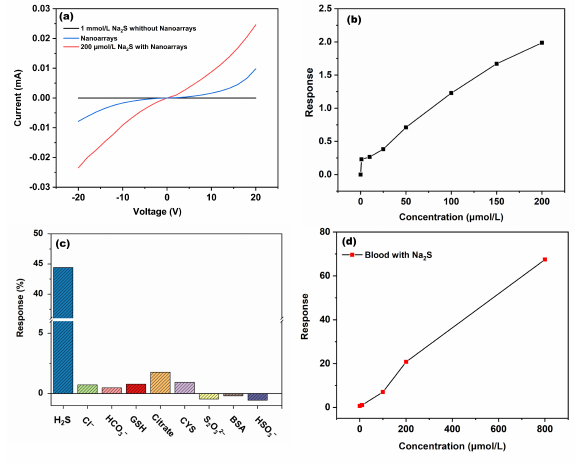
Fig. 5. (a) I-V characteristics of the Cu 2 O/NiO nanoarrays-based sensor. (b) Responses of sensors to different concentrations of Na 2 S (0, 1, 10, 25, 50, 100, 150 and 200 µ mol/L). (c) Responses (%) of the sensor to bio-H 2 S analyte (50 µ mol/L) and any other analytes (1 mmol/L). (d) The sensors’ responses to pure rat blood and Na 2 S added rat blood (the Na 2 S concentration are 10, 100, 200 and 800 µ mol/L, respectively).